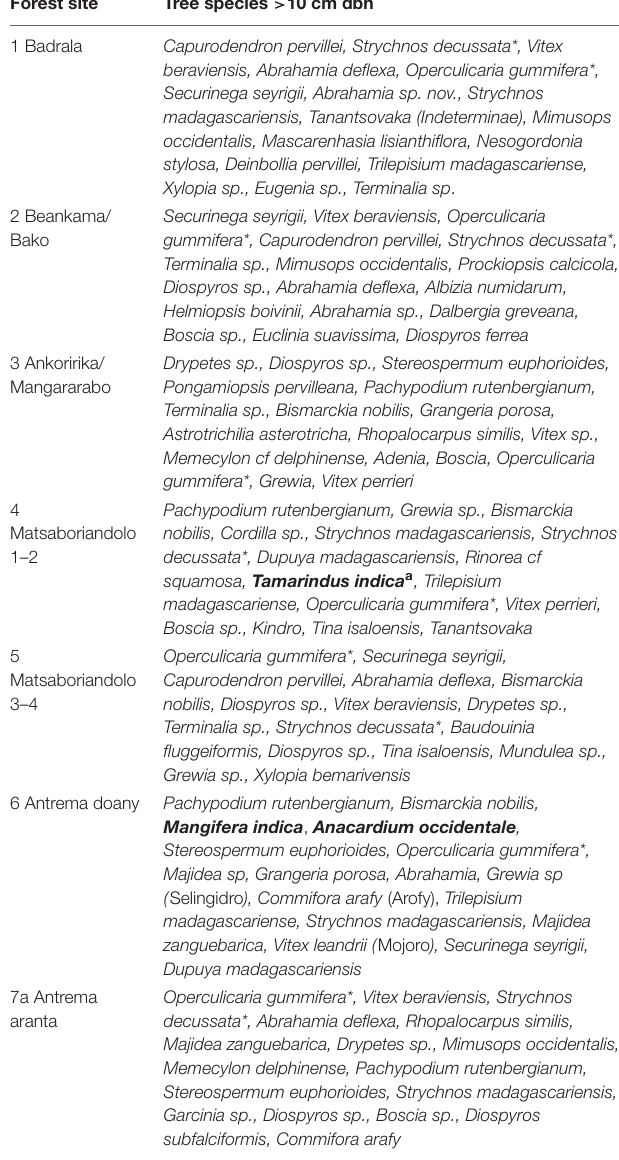
TABLE 2 | Major tree plant species (listed in descending order of the IVI) in each forest